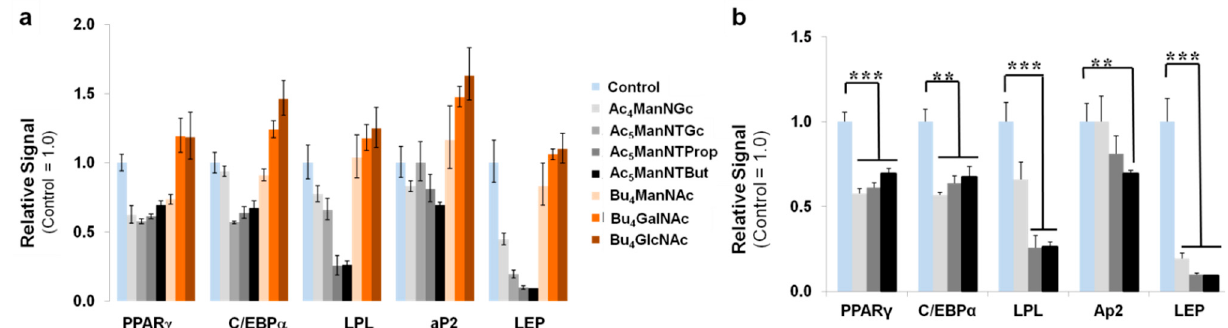
Figure 6. Transcript analysis of adipogenic differentiation in hASCs. ( a ) qRT-PCR analysis for adipogenic differentiation markers after Day 7 of treatment with a panel of analogs in adipogenic medium. Markers tested are PPAR γ (peroxisome proliferator-activated receptor γ ), C/EBP α (CCAAT/enhancer-binding protein α ), LPL (lipoprotein lipase, an early indicator of adipocyte differentiation), aP2 (fatty acid-binding protein 4, FABP4, intermediate marker of adipocyte differentiation), and LEP (leptin, a late marker of adipocyte differentiation). Statistical analysis of the RT-PCR was carried out using the (2 − ∆∆ Ct ) method, which calculates the relative changes in mRNA levels normalized to an endogenous reference (GAPDH) relative to a calibrator (without analog treatment) that serves as the control group and was expressed as fold change; these analyses showed the strongest suppression occurred in Ac 5 ManNTProp- and Ac 5 ManNTBut-treated hASCs ( b ). (** indicates p < 0.01 and *** indicates p < 0.001).